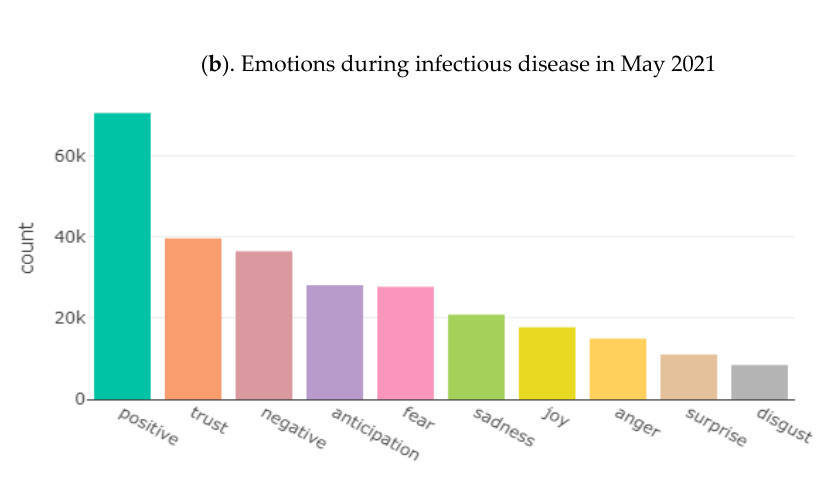
Figure 1. Emotions during infectious disease.